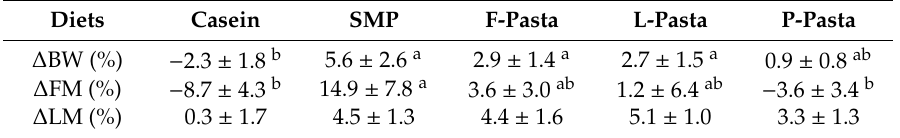
Figure 1. Bodyweight ( A ), fat mass ( B ), and lean mass ( C ) variations during the time. The results are expressed as means ± SEM; Means with different letters are significantly different ( p < 0.05). W0, W3, and W6 = the beginning, the middle, and the end of the experiment, respectively; BW = bodyweight; FM = fat mass; LM = lean mass; F-pasta = faba bean-enriched pasta; L-pasta = lentil-enriched pasta; P-pasta = split pea-enriched pasta; and, SMP = soluble milk proteins. Table 3. Body composition of old rats after six weeks of diet.